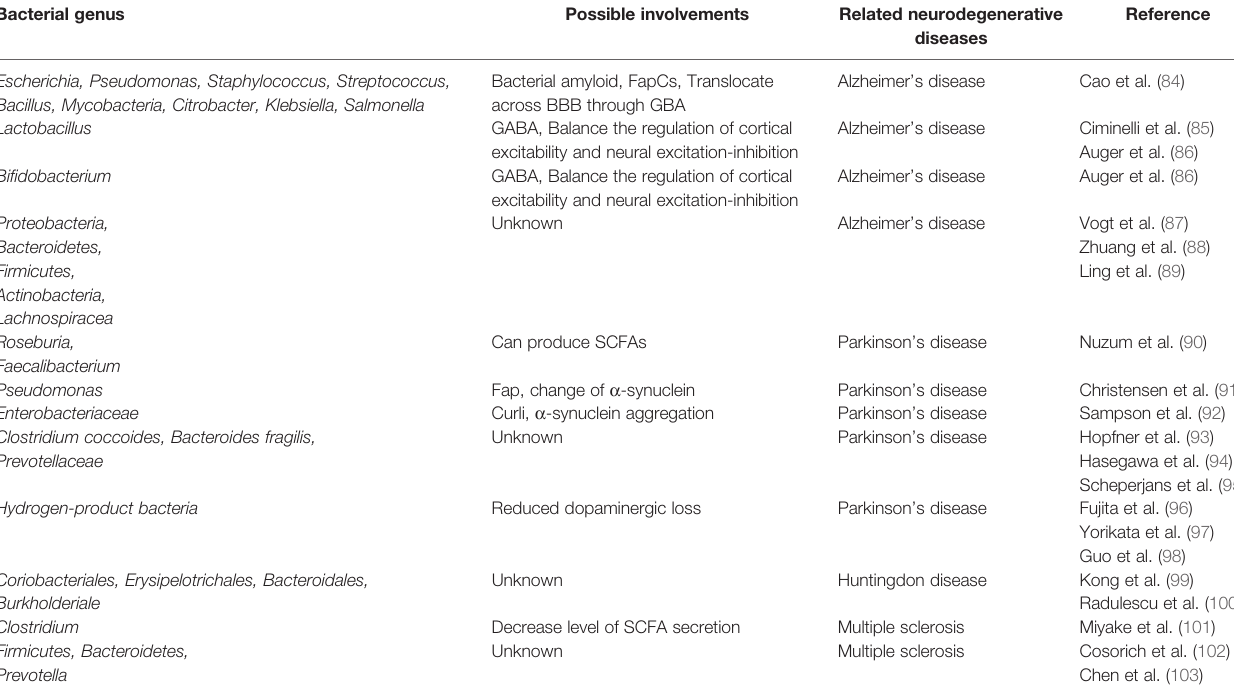
TABLE 1 | Involvements of gut microbiota in neurodegenerative